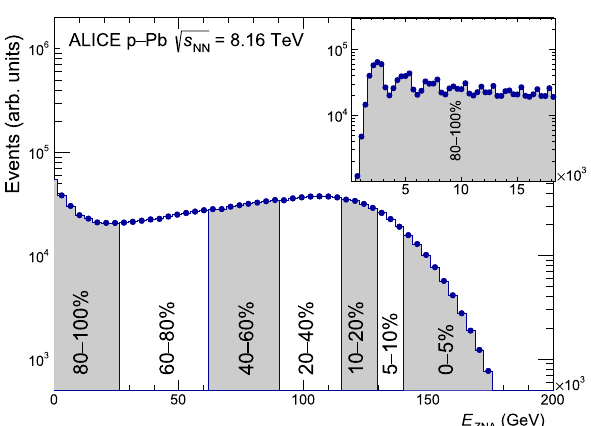
Fig. 2 Distribution of the neutron energy spectrum measured in the Pb-going side (ZNA). Centrality classes are indicated by vertical lines